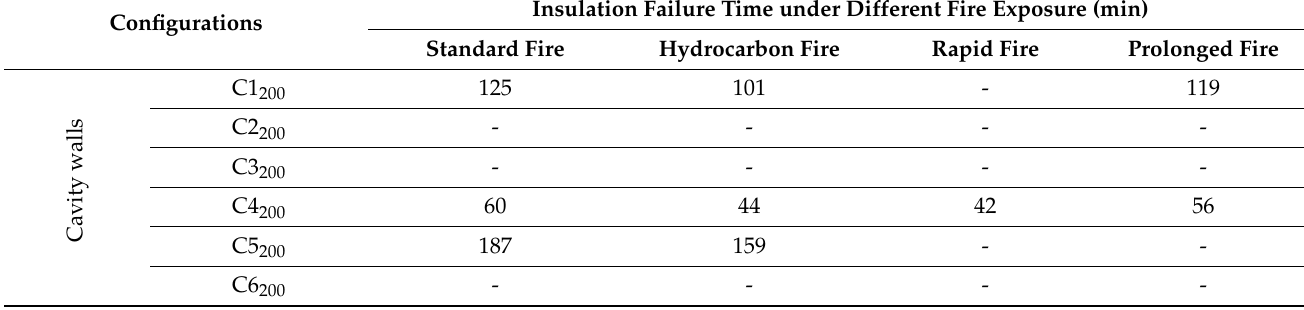
Table 6. Insulation fire ratings for 3D-printed concrete cavity walls (200 mm